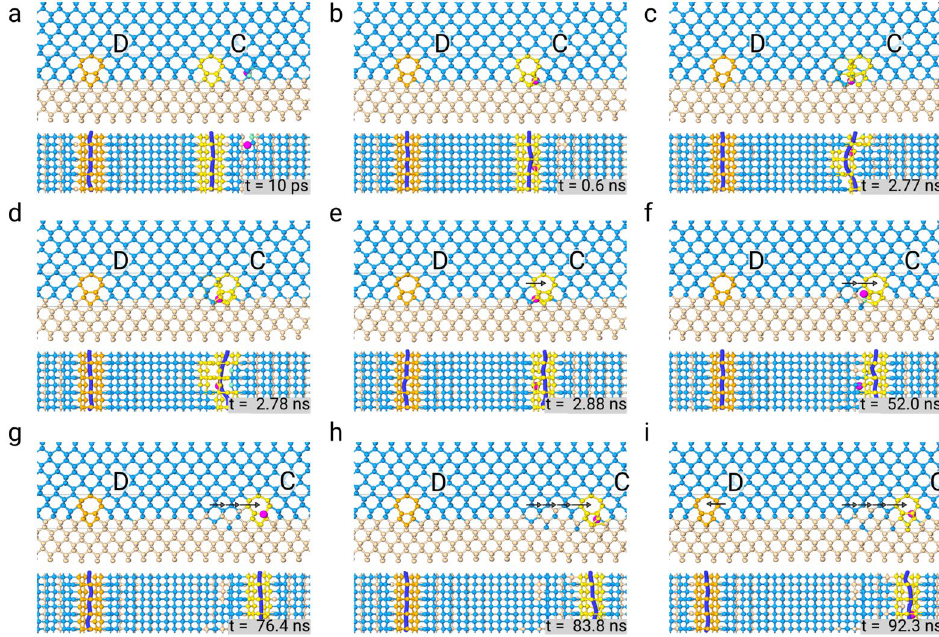
Figure 5. Simulation of 90 ◦ edge dislocation vacancy-assisted glide. Relevant snapshots of the evolution are shown. Light blue spheres represent Ge atoms, pink spheres Si atoms, yellow spheres highlight the core of the dislocation “C” on the right (Burgers vector � b = a / 2 [¯ 110 ] ), orange spheres highlight the core of the identical dislocation “D” on the left (Burgers vector � b = a / 2 [¯ 110 ] ). The vacancy, as identified by Wigner–Seitz defect analysis in Ovito, is depicted as a big purple sphere. For each configuration, a top view of a slice around the defects is provided below each snapshot. Thin black lines indicate the sliced region of each snapshot. Simulation snapshots are provided in sequence ( a – i ), and the corresponding simulation time is shown in the inset. Black arrows indicate the displacement of the